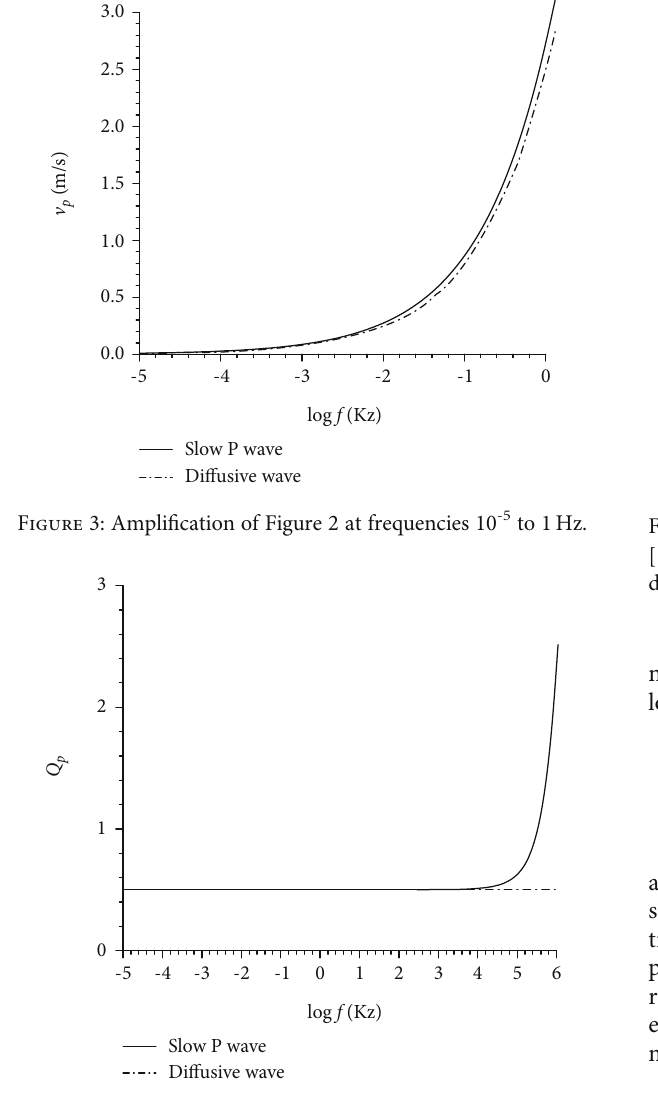
Figure 4: Same as Figure 2 except for the quality factor ( Q